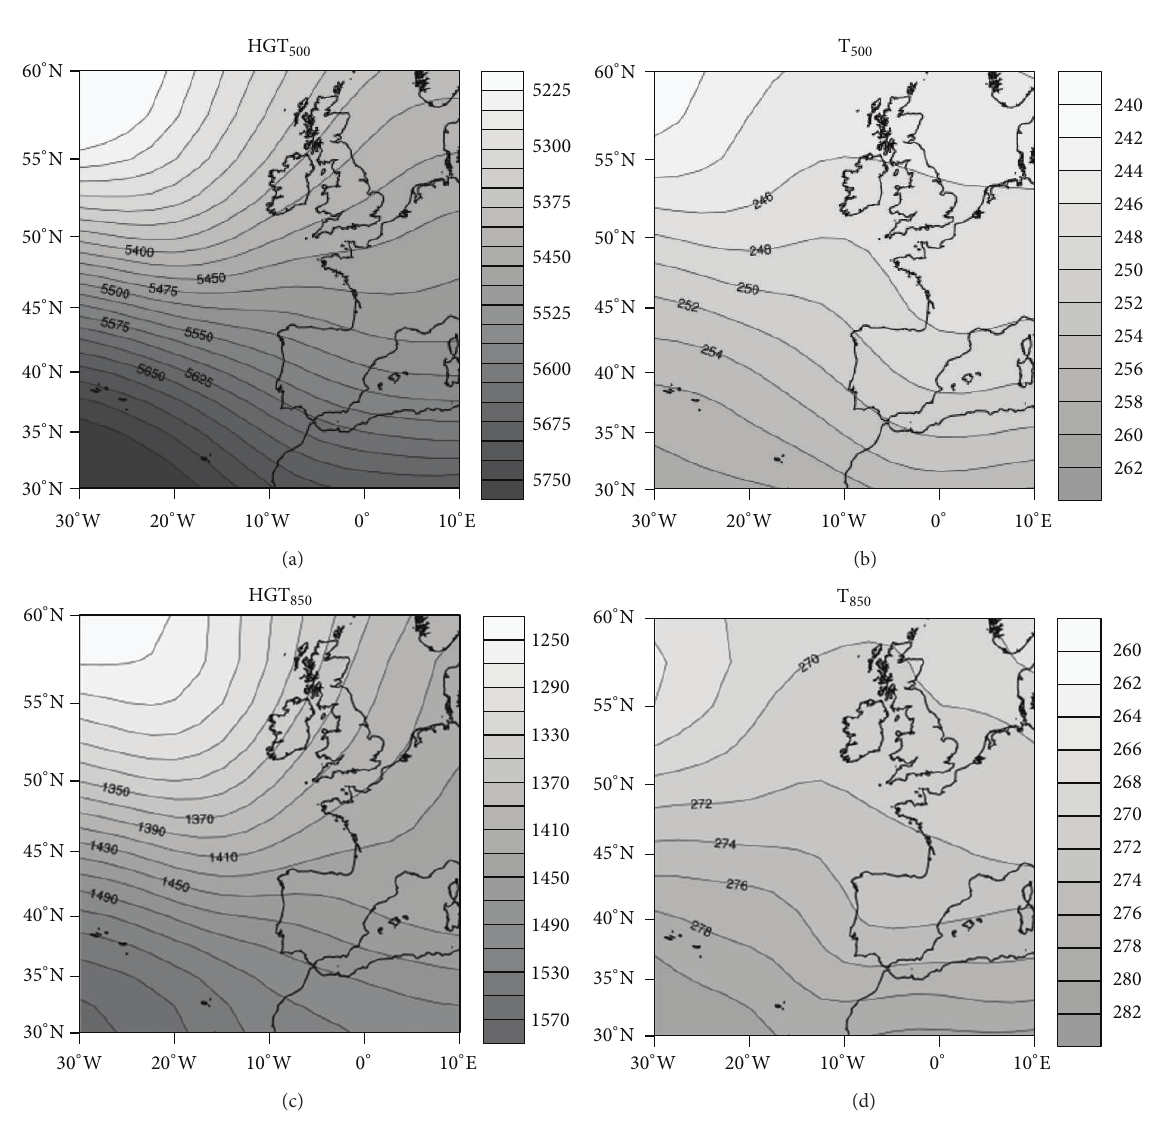
Figure 6: As in Figure 2 but for cluster